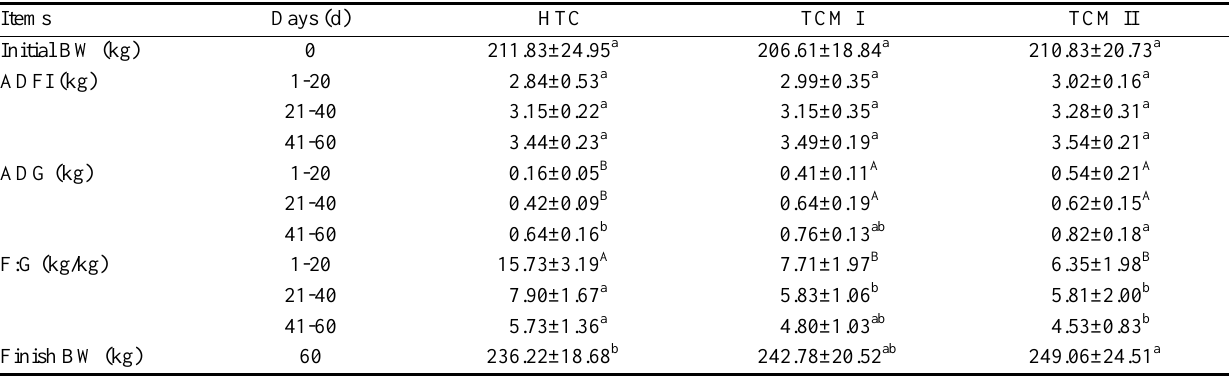
Table 7. Effects of two TCM treatments on growth performance of heat stressed beef